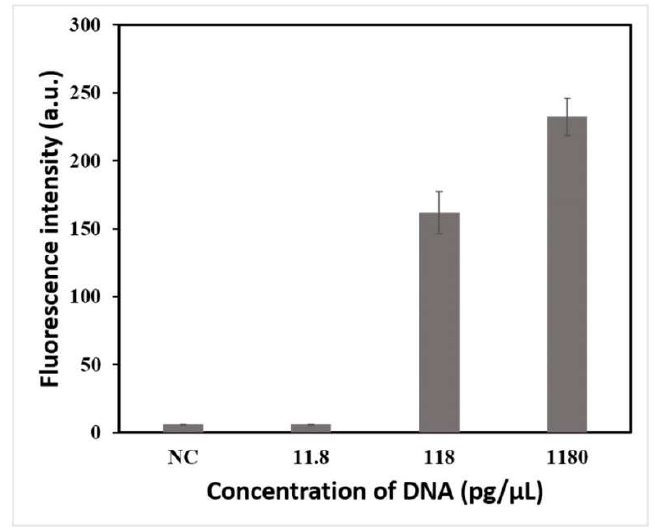
Figure 3. Detection limit test results of LAMP–CRISPR/Cas12a detection system for Salmonella detection using 10-fold serial dilutions of crude genomic DNA in ddH 2 O (diluted from 1180 pg/μL to 11.8 pg/μL).